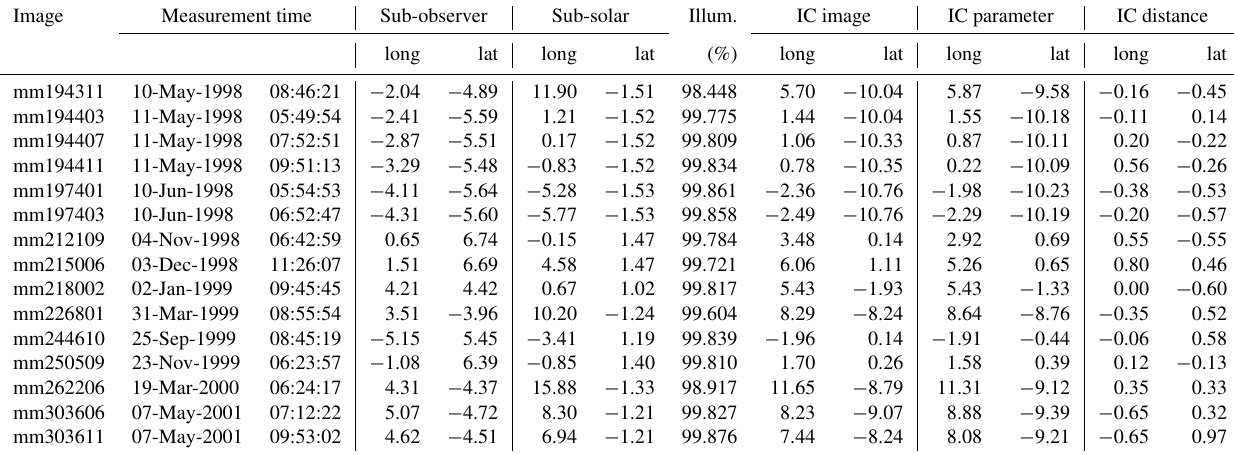
Table 1. The ROLO reference images with sub-observer and sub-solar point coordinates and the lunar phase as illumination in percent. The intensity centroid “IC image” is determined from the SFD simulation. The “IC parameter” is calculated with the fitted parameters. The distance in degree between the two ICs is given in the last two columns. The distance standard deviation in latitude is 0.51 ◦ and in longitude is 0.42 ◦ .